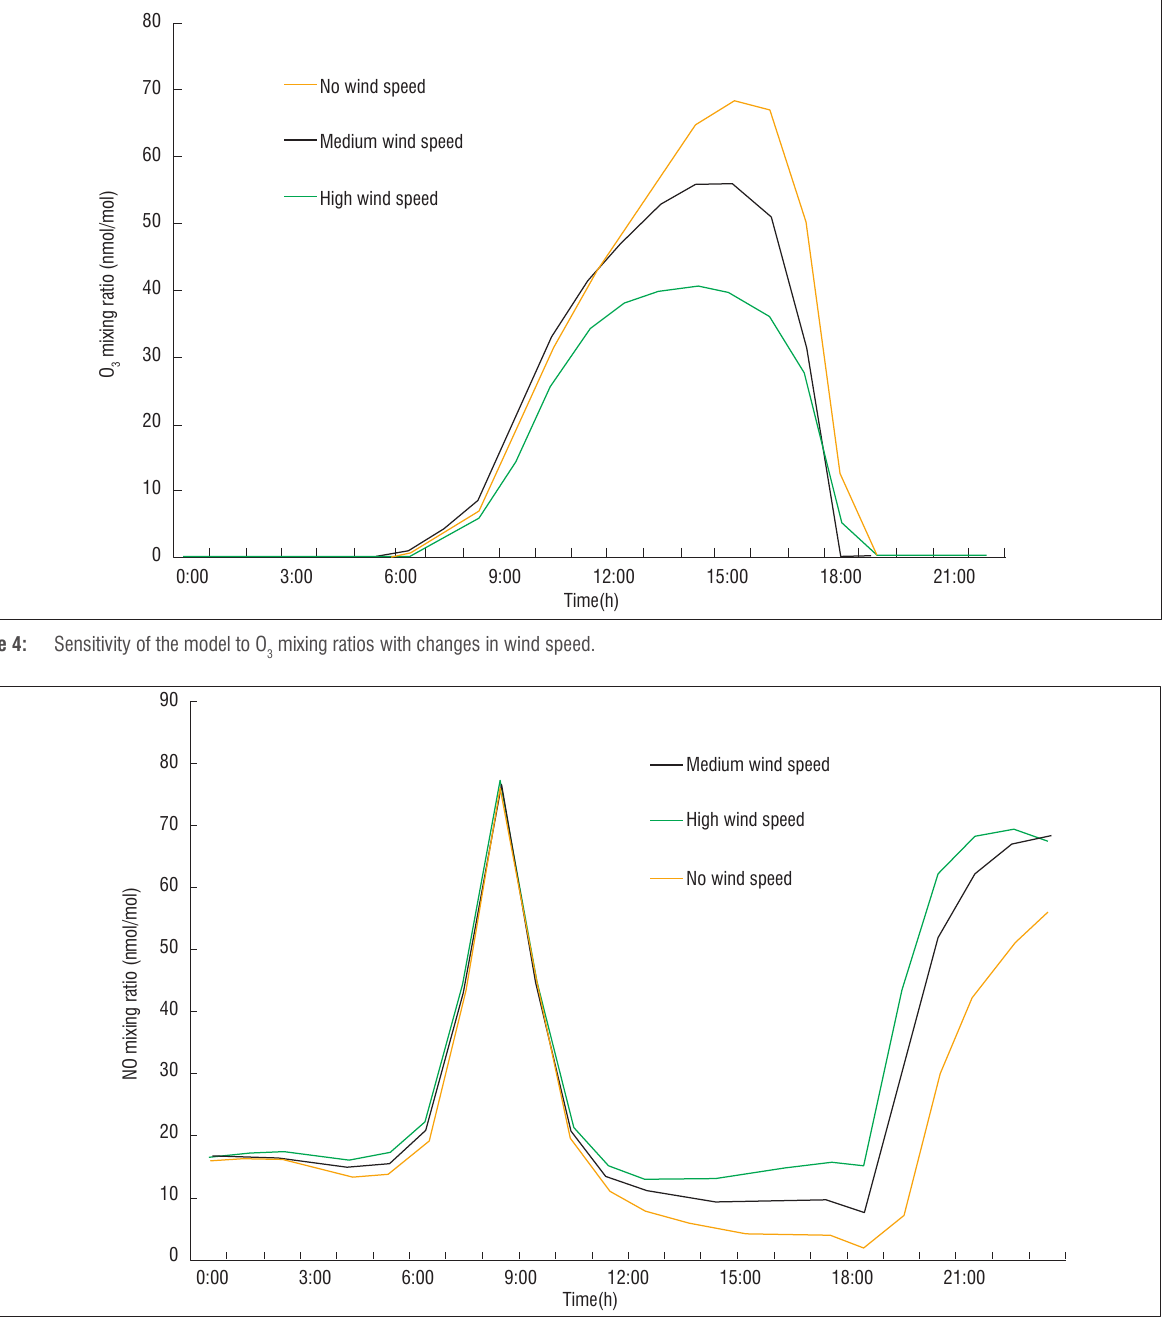
Figure 5: Sensitivity of the model to NO mixing ratios with changes in wind